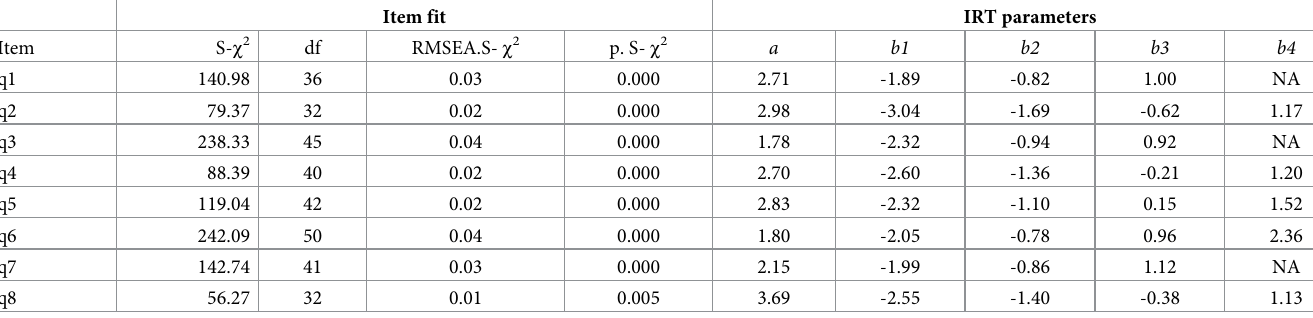
Table 5. Item characteristics, item fit and IRT parameters of the